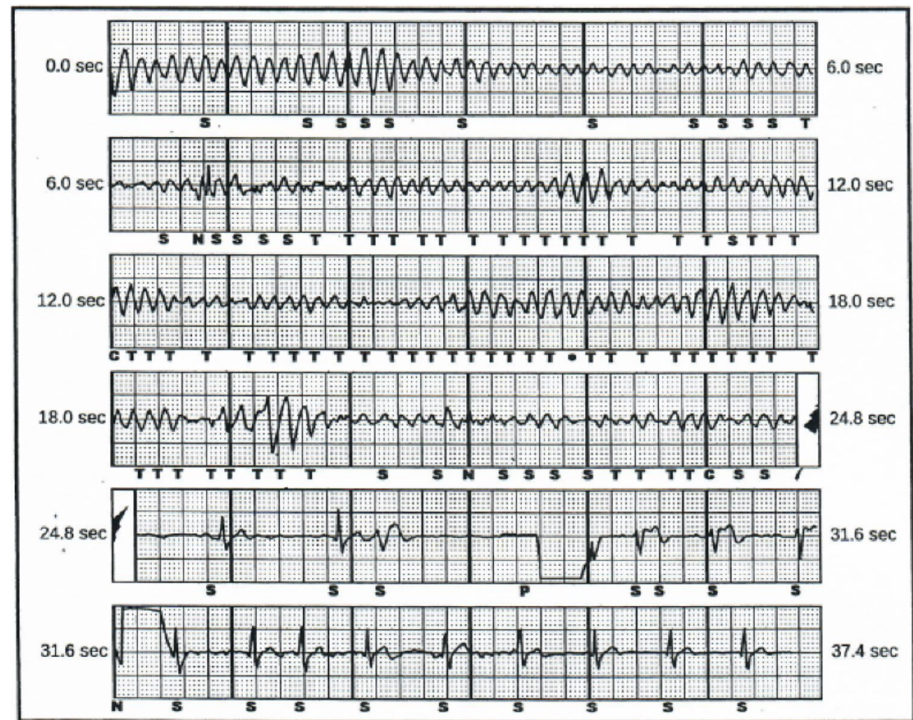
Figure 2. Subcutaneous electrocardiogram showing ventricular fibrillation episode, treated with effective S-ICD shock. Termination of the arrhythmia is followed by sinus beats (S) and, alternately, ventricular extrasystoles of different morphologies (S). One of the beats is a subcutaneously paced beat (P).